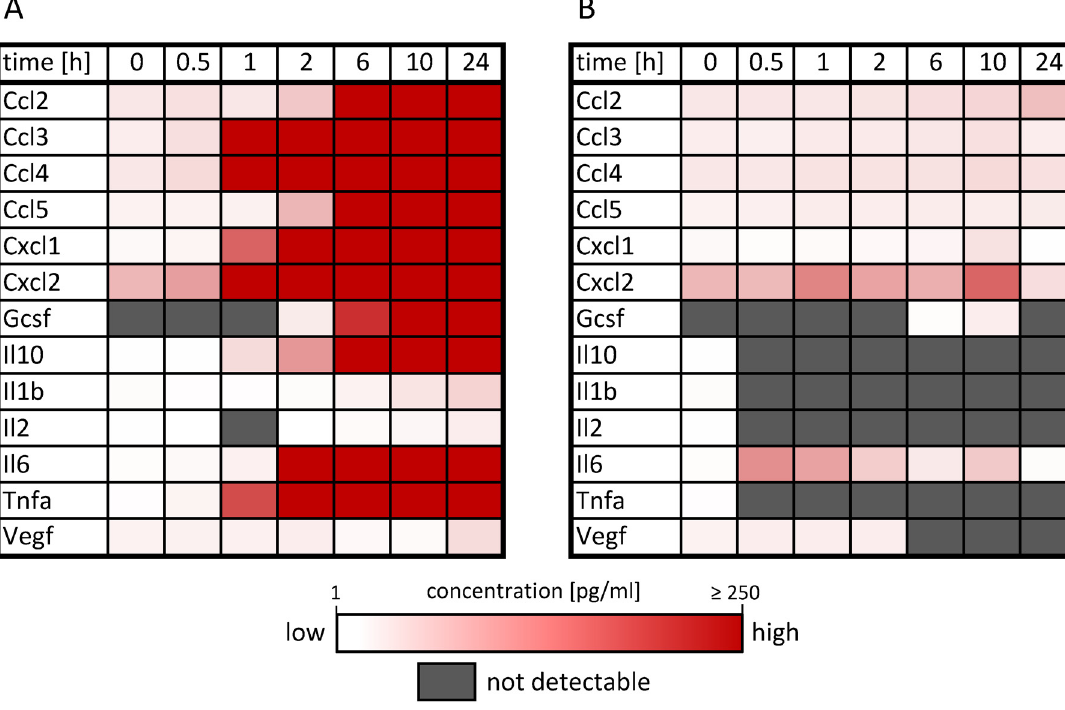
Fig 10. Protein secretion pattern of activated macrophages. Supernatant from macrophages ((1 x 10 6 cells) treated with (A) LPS or (B) IL-4/13 analyzed via Luminex Technology at the indicated time points. For specific concentrations as well as standard deviation, number of samples and p-values for secretion compared to untreated controls we refer to S2 Dataset.